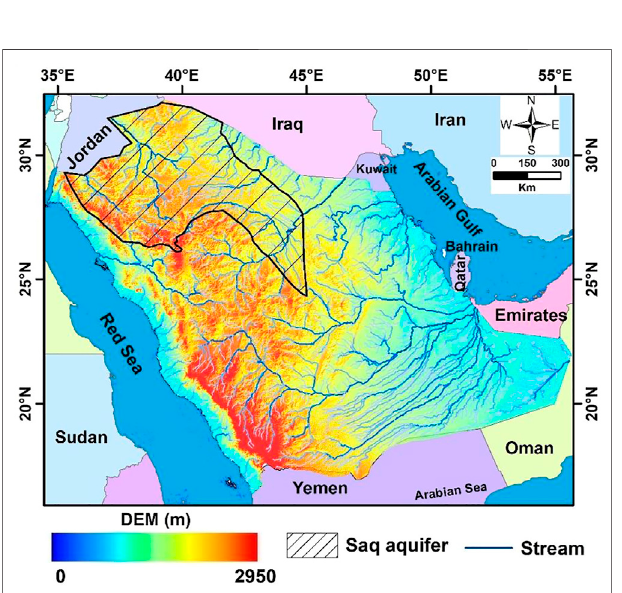
FIGURE 14 | Time series for groundwater storage variation estimated from the different GRACE sources over the Saq aquifer and their averaging (Avg-GWS).